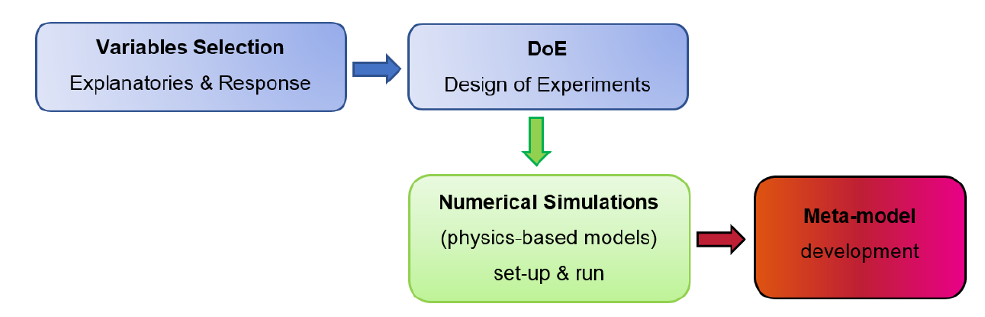
Figure 4. Flowchart of the